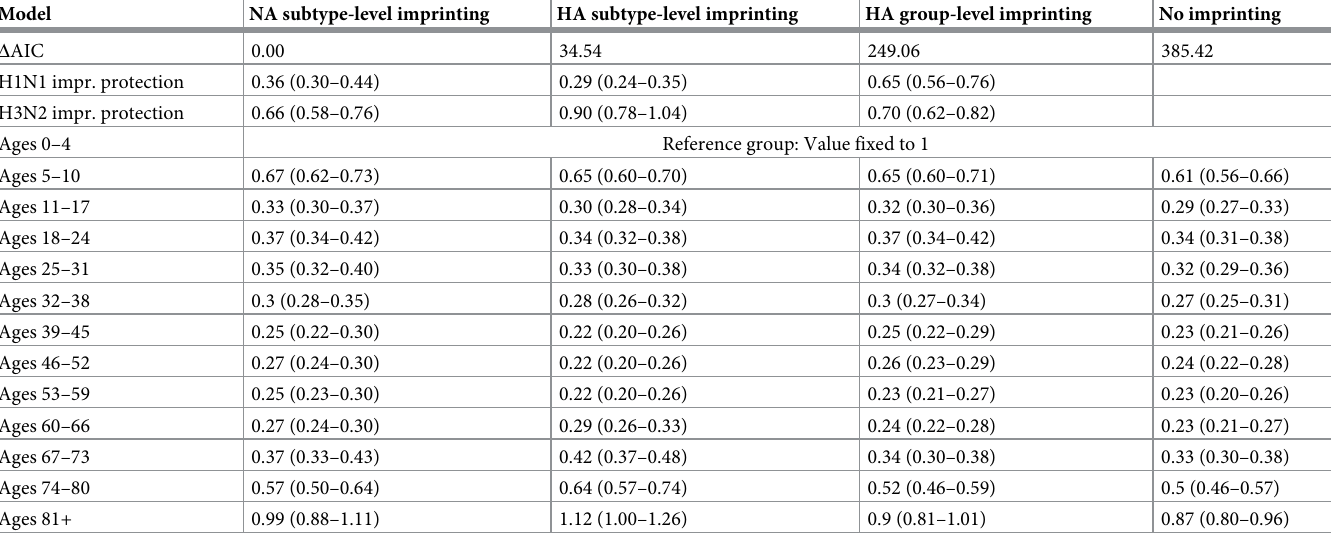
Table 2. Maximum likelihood parameter estimates and 95% profile confidence